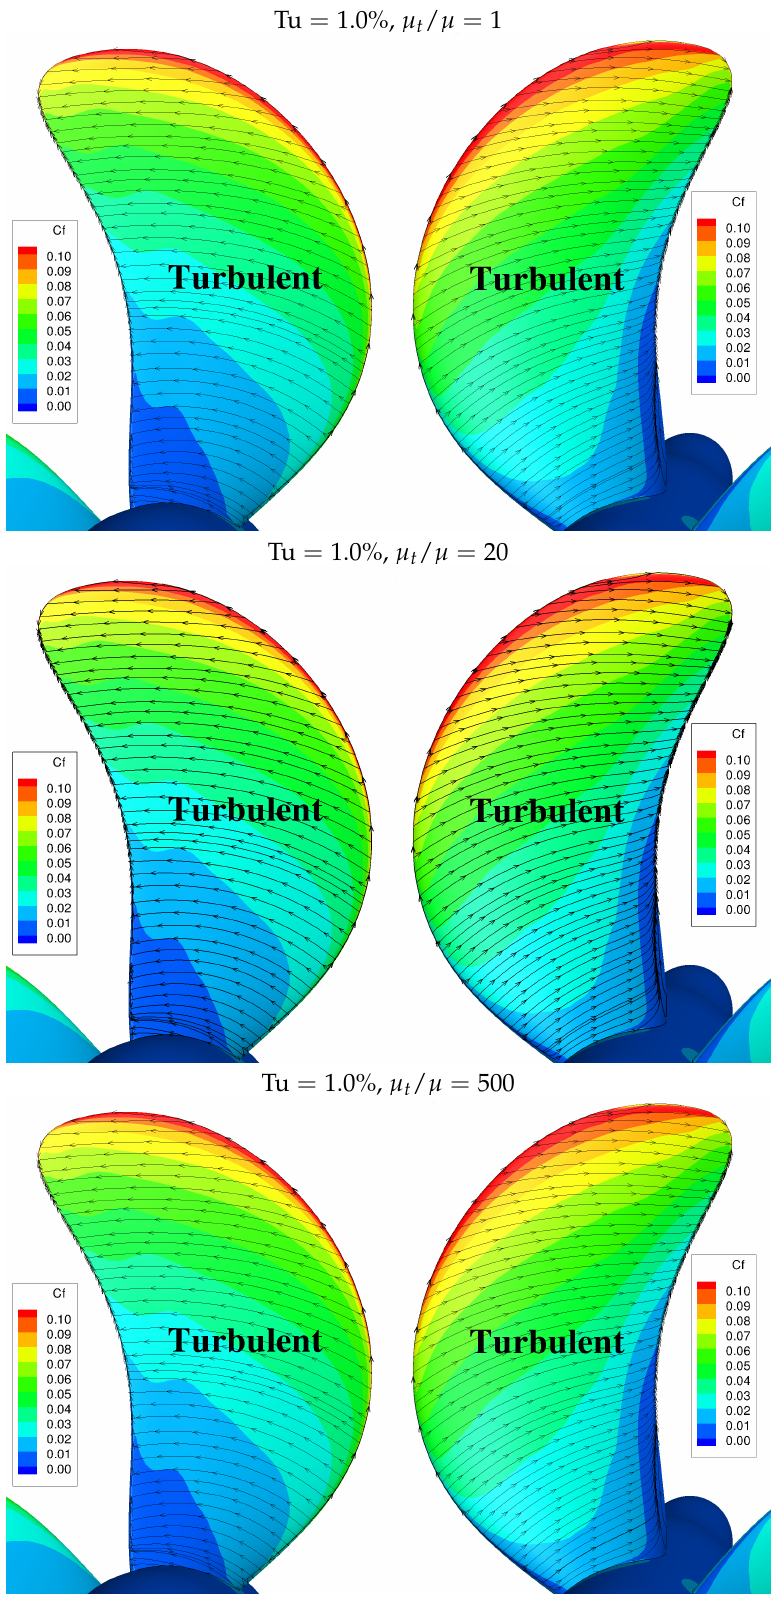
Figure 12. Influence of the inlet turbulence quantities on the propeller blade flow. Limiting stream- lines and skin friction coefficient using the k − ω SST turbulence model at Re = 1 × 10 7 for J = 0.568. Pressure side ( left ) and suction side ( right